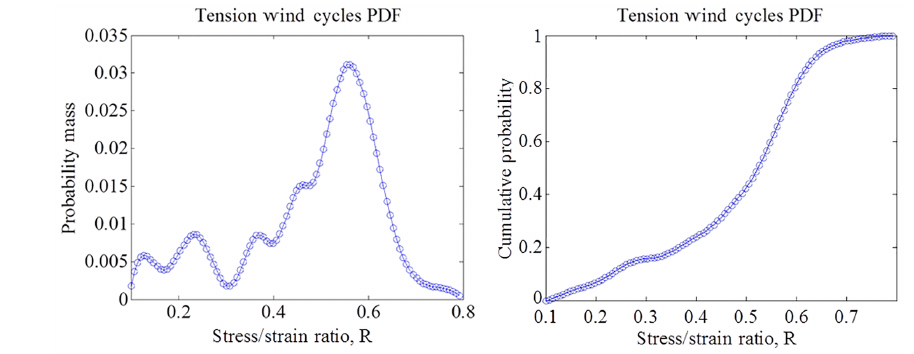
Figure 8. Wind cycle distributions for high pressure side from WISPER data (Tenhave, 1992).